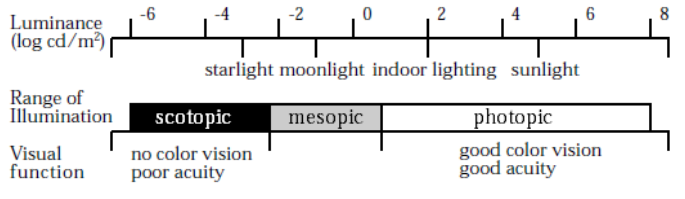
Figure 3. Dynamic Range of the Visual System Adapted from [18].